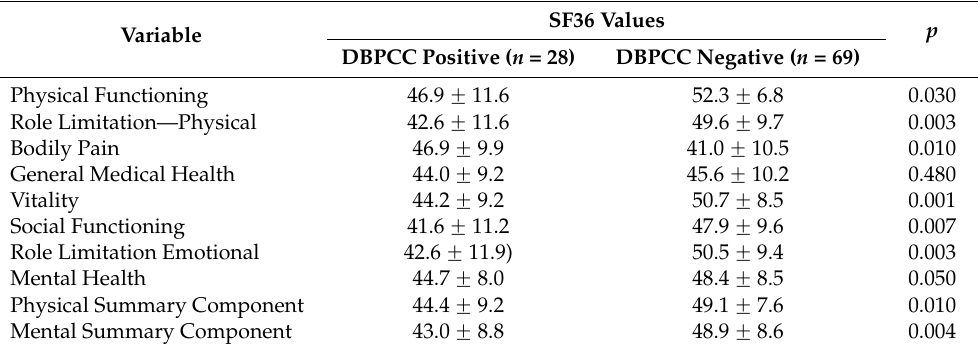
Table 5. SF36 scores of patients positive and negative to the gluten challenge. Noteworthy, in patients positive to the gluten challenge, a deterioration of satisfaction after gluten assumption is associated with a significantly reduced SF36